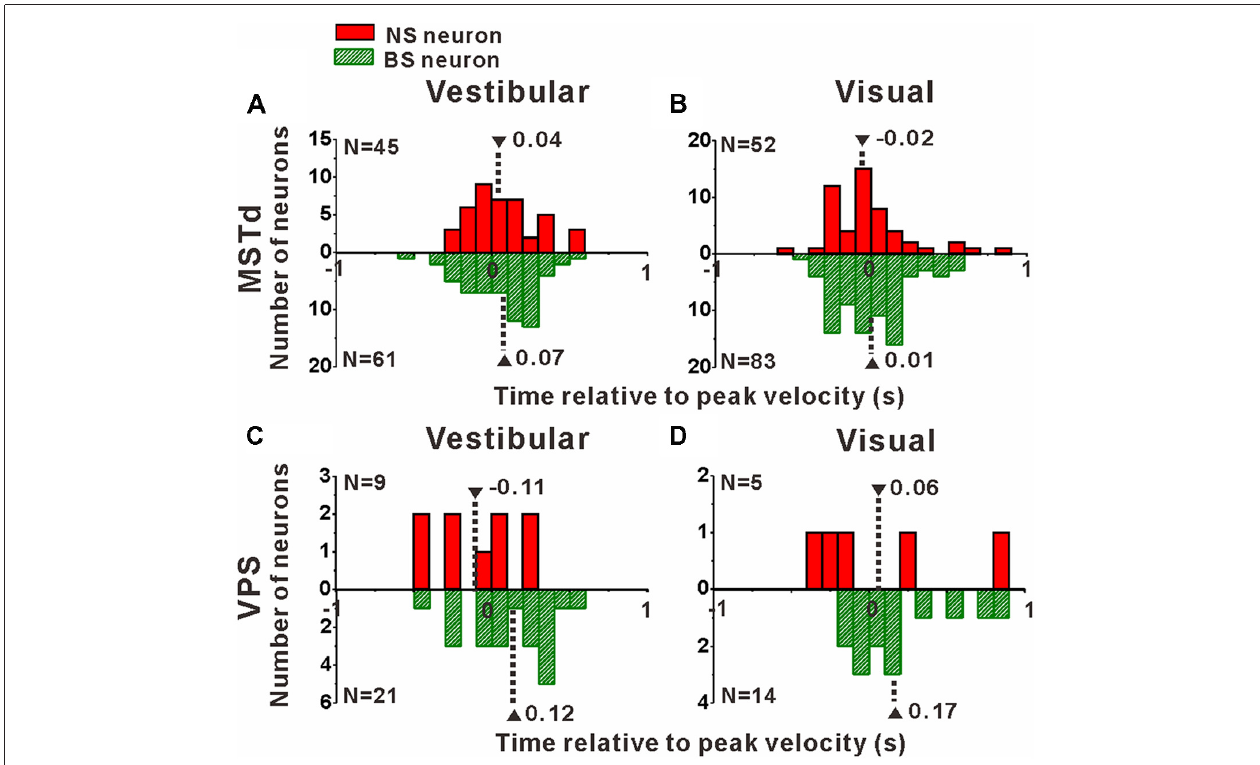
FIGURE 8 | Peak times of the NS (red) neurons and BS (green) neurons in areas MSTd (A,B) and VPS (C,D) under the vestibular and visual conditions. The neurons analyzed in the graph have a significant directional tune to vestibular or visual stimuli (both p < 0.05, ANOVA test). The number of neurons were same as in Figure 4 . Note that the number of significant direction distributions for BS neurons were plotted as downward projecting histograms simply for illustrative